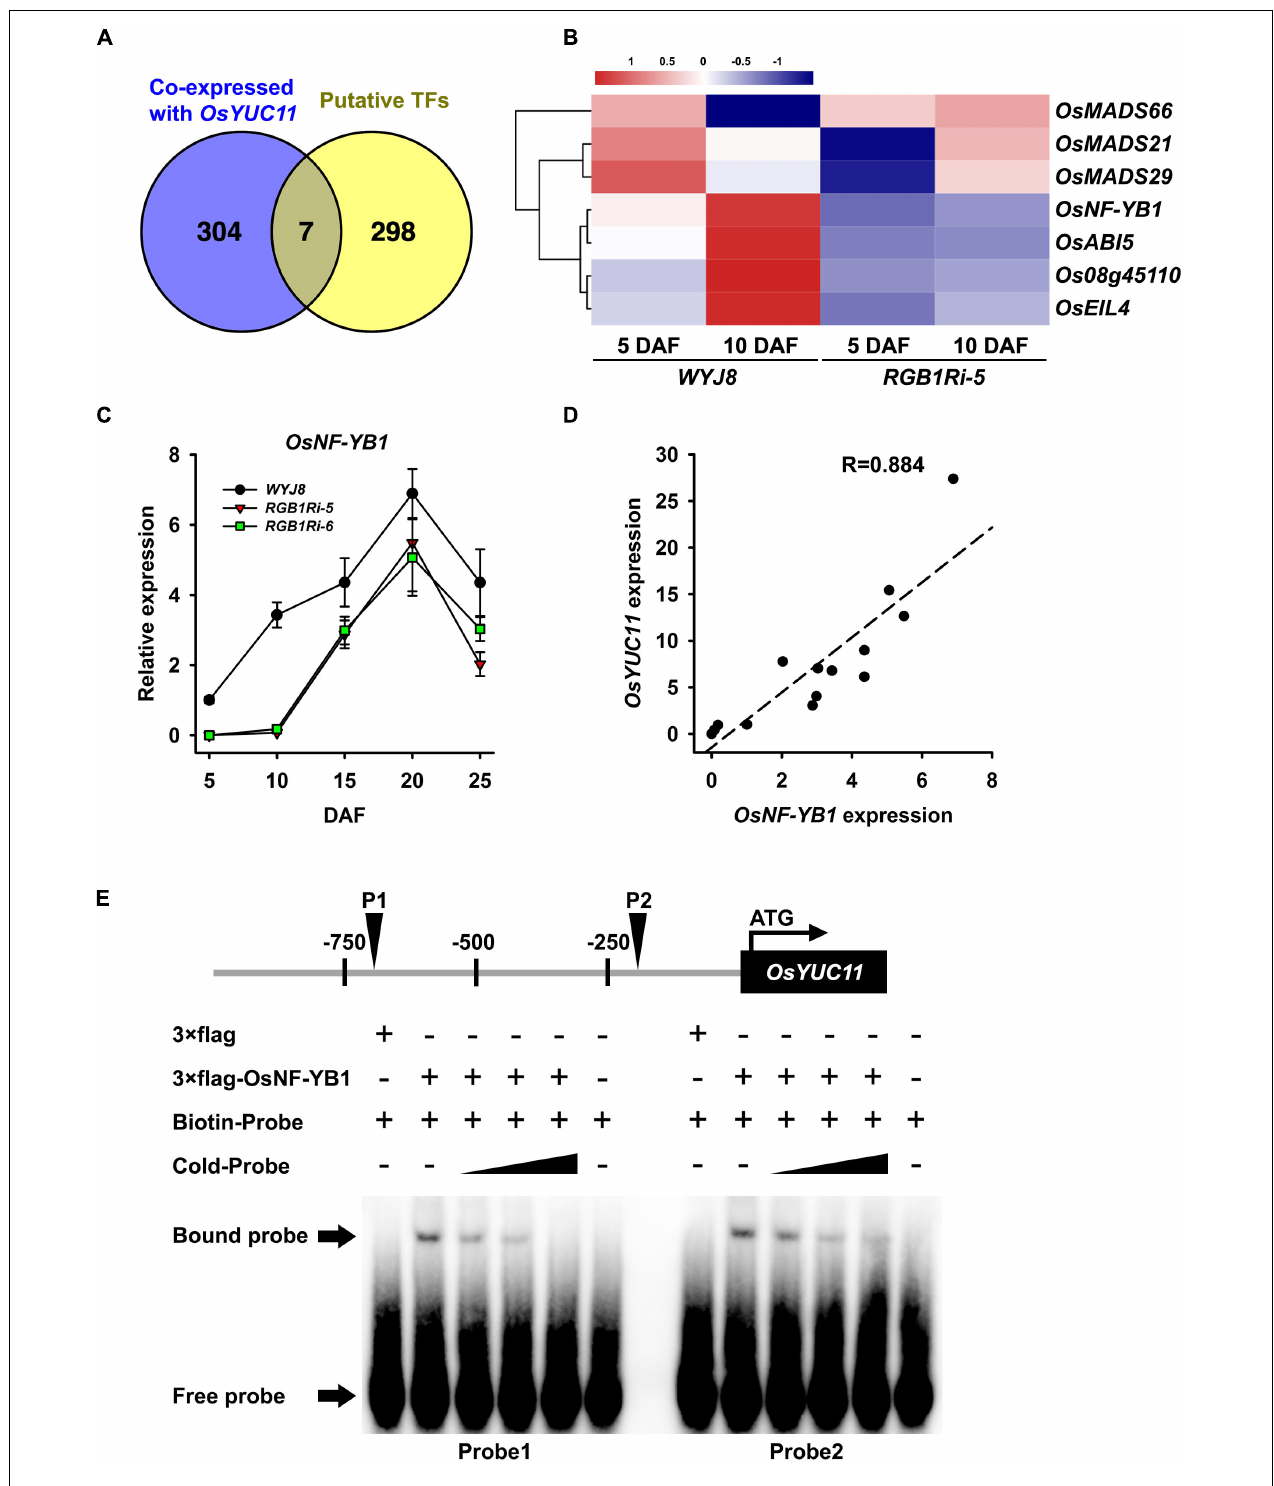
FIGURE 5 | The transcript factor OsNF-YB1 directly interacts with promoter of OsYUC11 . (A) Venn diagram showing number of genes included in co-expressed with OsYUC11 and putative transcript factors which bind to the promoter of OsYUC11 . Venn diagram has been generated using Venn (http://bioinfogp.cnb.csic.es/tools/venny/index.html). (B) Heat map of the expression of candidate transcript factors in WYJ8 and RGB1Ri line during filling stage. (C) Expression of OsNF-YB1 in WYJ8 and RGB1Ri lines. (D) Correlation between the expression of OsYUC11 and OsNF-YB1 . (E) EMSA assay showing OsNF-YB1 binding to the OsYUC11 promoter in vitro